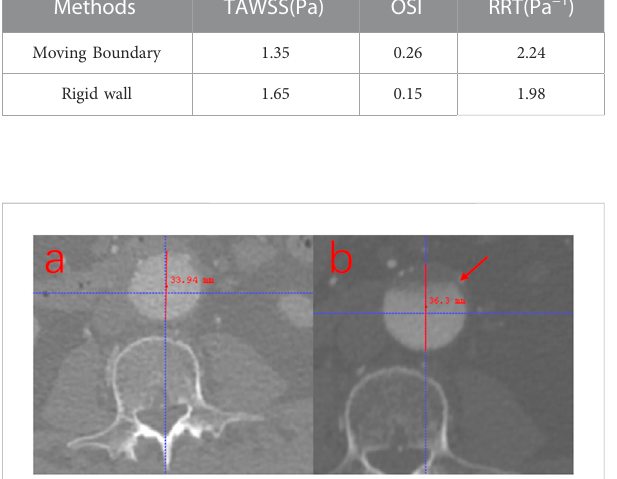
TABLE 2 Comparison of the mean value of three parameters on the vessel wall by using two methods.